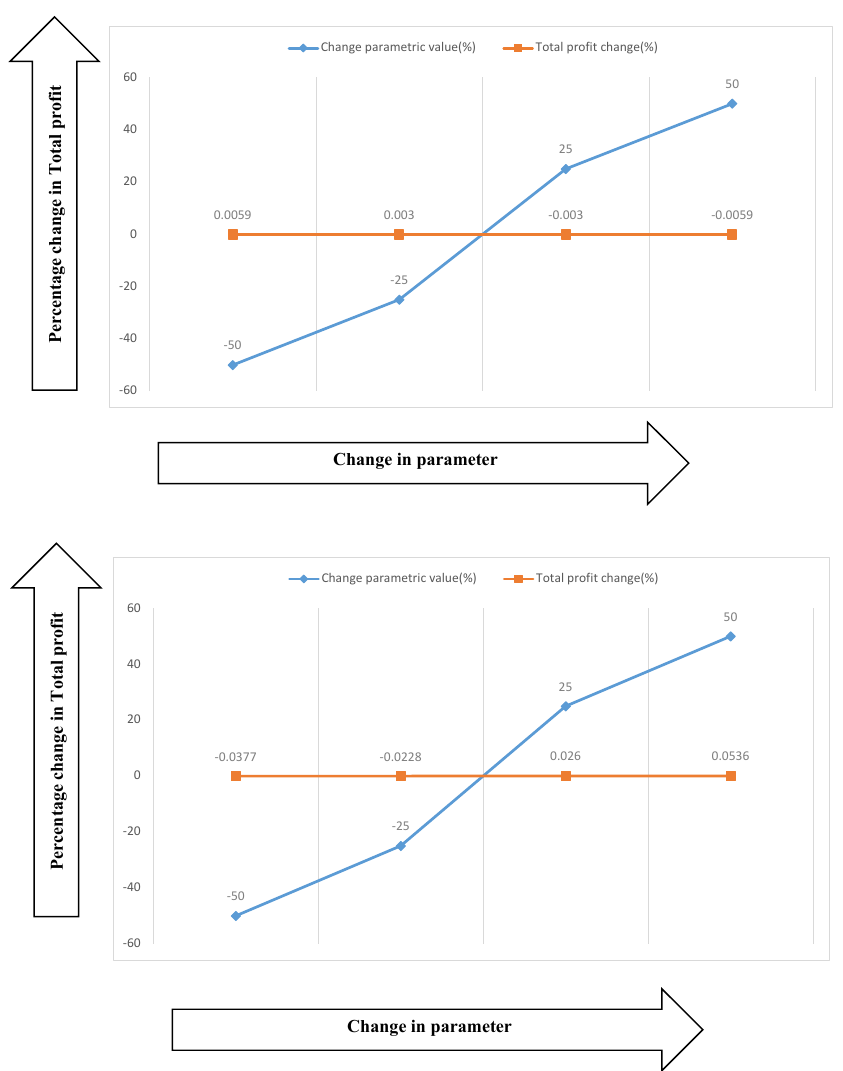
Figure 7. Changes in parameters β 0 and π 0 versus percentage change in total profit,